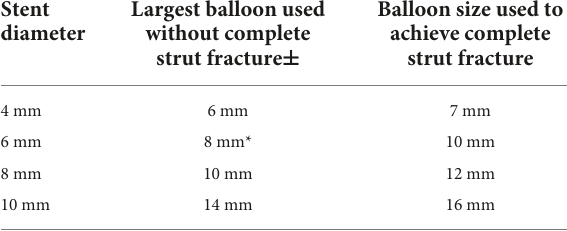
Balloon size used to achieve complete strut